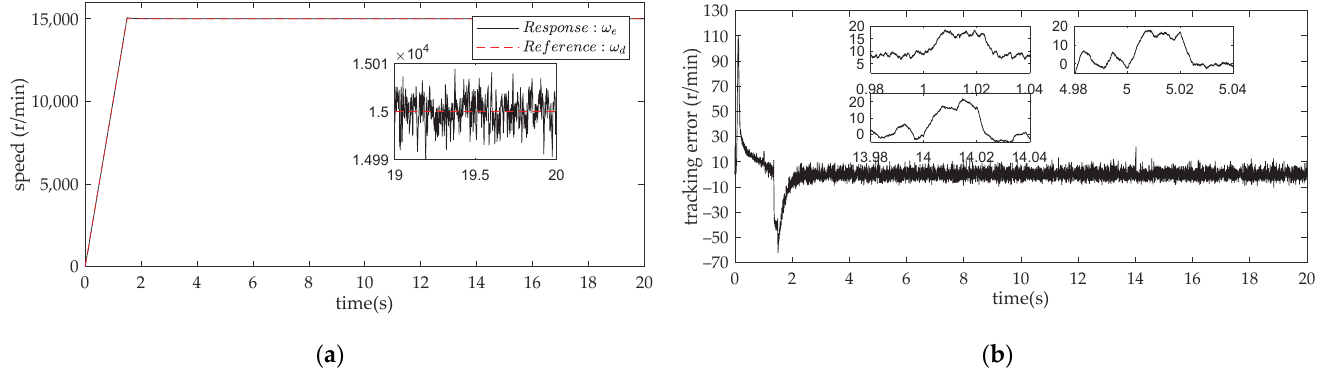
Figure 9. ( a ) Speed response of PID control in case of external disturbances; ( b ) PID tracking error in case of external disturbances.